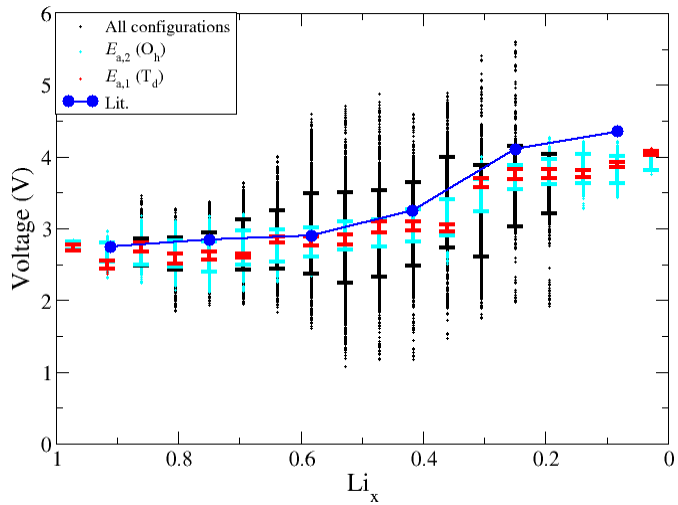
Figure 10. Voltage predictions after removing configurations with Ni dropping into tetrahedral sites. Voltage predictions for all configurations, configurations below E a,2 and those below E a,1 are shown in black, cyan, and red, respectively. Standard deviations are also included. Table 2. Tabulated are the changes in the Li–Li distribution compared to the fully lithiated struc- ture.